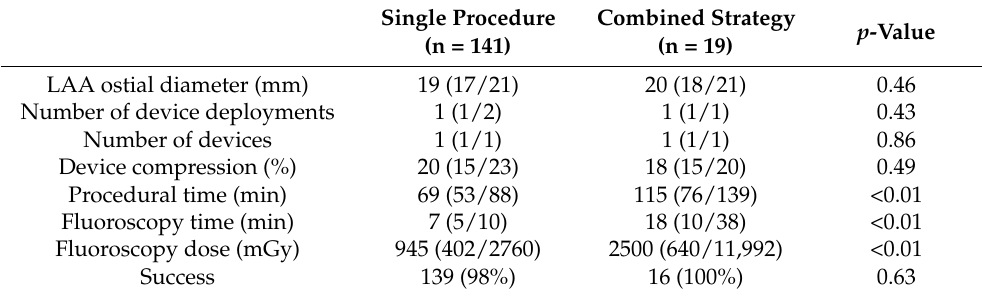
Table 2. Left Atrial Appendage Closure